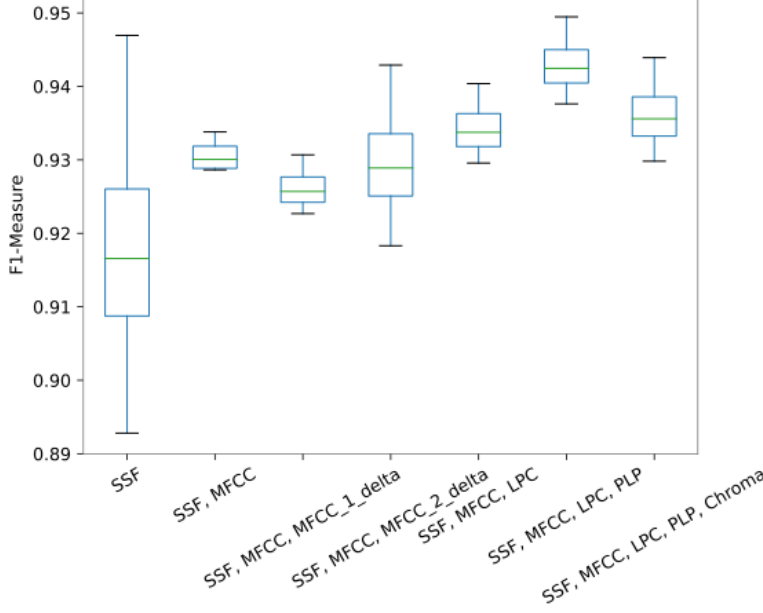
Figure 6. Performance of the best possible feature combinations in the Jamendo dataset. From the results on the Jamendo dataset shown in Figure 6, SSF, MFCC, LPCC, and PLP was the feature combination that achieved the best performance. For the Electrobyte dataset in Figure 7, the best feature combination was SSF and PLP. With the observations from both datasets, the combined features were set as the SSF and